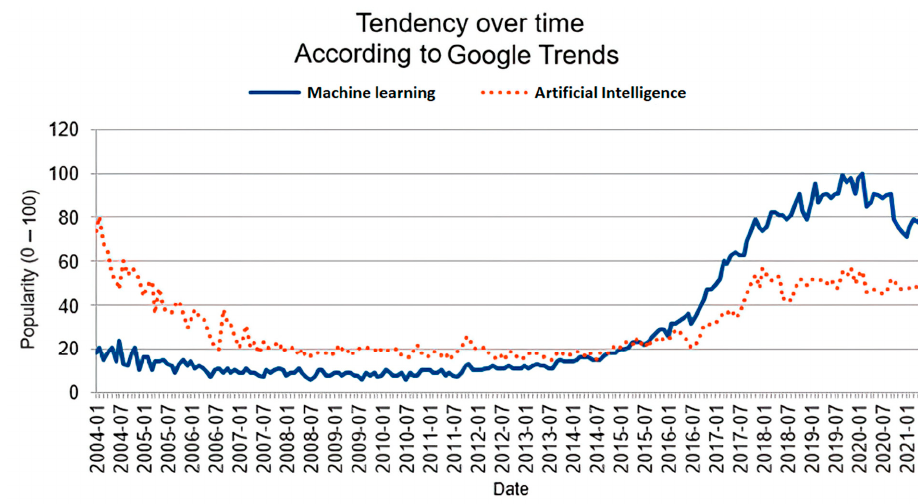
Figure 3. Global historic tendency of “Machine learning” vs. “Artificial Intelligence”.